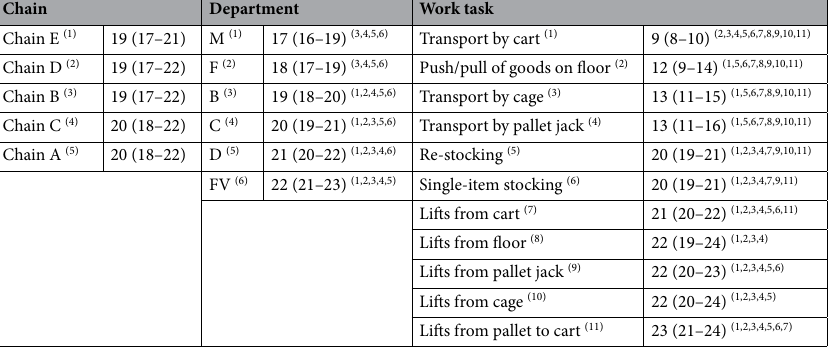
Table 5. Neck/shoulder muscular workload during supermarket stocking for chains, departments, and work tasks presented as least square means (LSM) with 95% confidence intervals of the 95th percentile rank of nRMS (% nRMS (95% CI)). n = 75 supermarket workers. B bread, C colonial, D dairy, F frozen goods, FV fruit and vegetables, M meat. Significant differences (p < 0.05) between chains, departments and work tasks, respectively, are indicated with numbers in superscript.